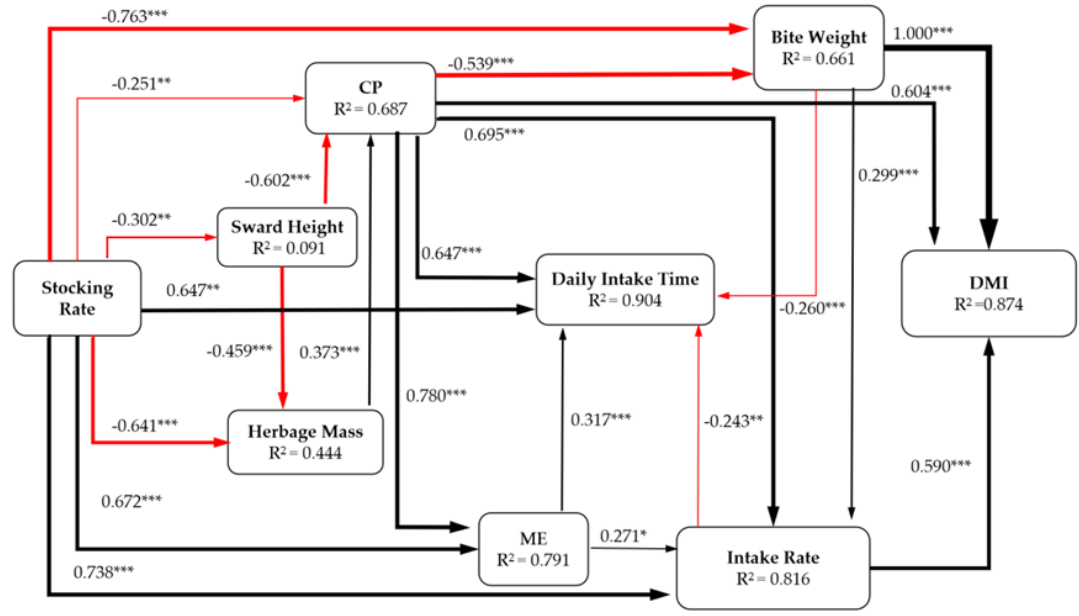
Figure 10. The SEM showed the effect of stocking rate on DMI. * p < 0.05, ** p < 0.01, *** p < 0.001 . The model shows a fitted result ( χ 2 = 10.770, df = 12, p = 0.459; RMSEA = 0.051, p = 0.541; GFI > 0.974). Stocking rate explained 68.7%, 9.1%, 44.4%, 79.1%, 81.6%, 66.1%, 90.4%, and 87.4% of the